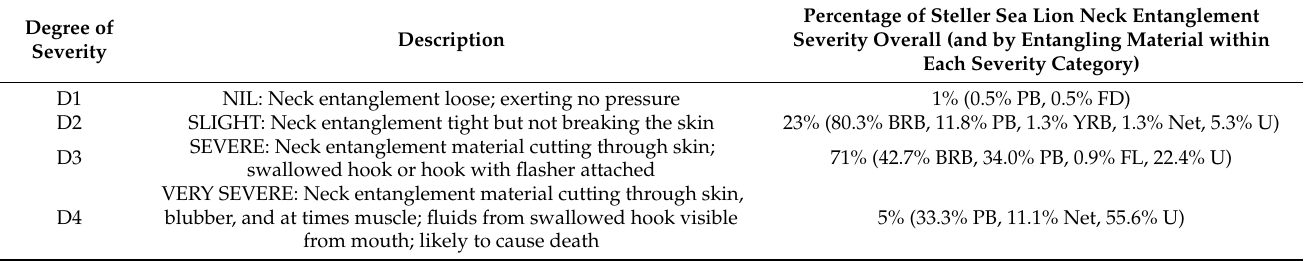
Table 1. Codes used to depict entanglement or ingestion severity and percentage of the degree of entanglement severity (overall and by entangling material within each severity category) of Steller sea lions observed from 2005–2009. Neck-entangling materials: PB = packing band; BRB = black rubber band; YRB = yellow rubber band; FD = flying disc; FL = flasher/lure; U = unknown.